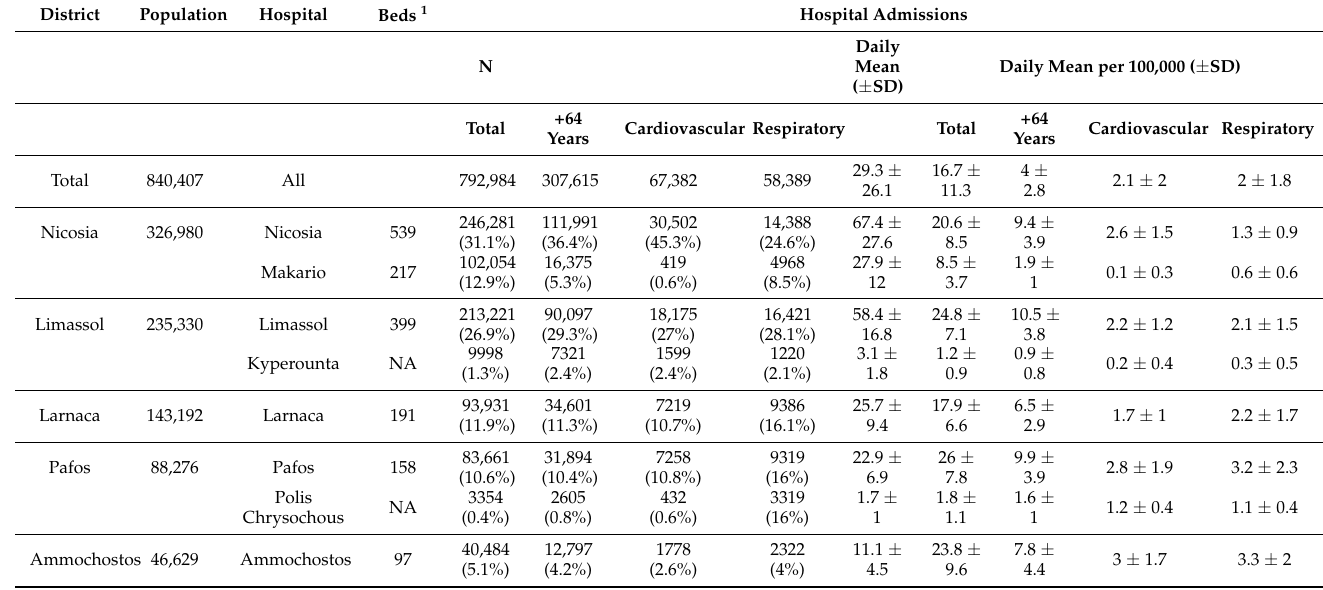
Table 1. Hospital admissions by hospital in Cyprus between 1 January 2009 and 31 December